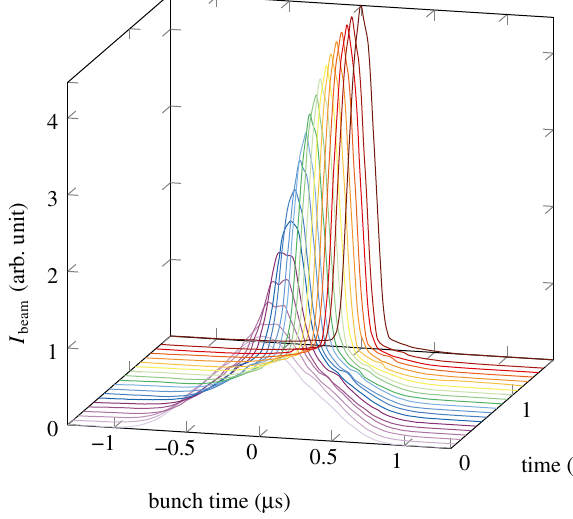
FIG. 14. Example of the evolution of the longitudinal bunch profile. Parameters as in Fig. 7. The cooling beam is switched on at t ¼ 0 . 1